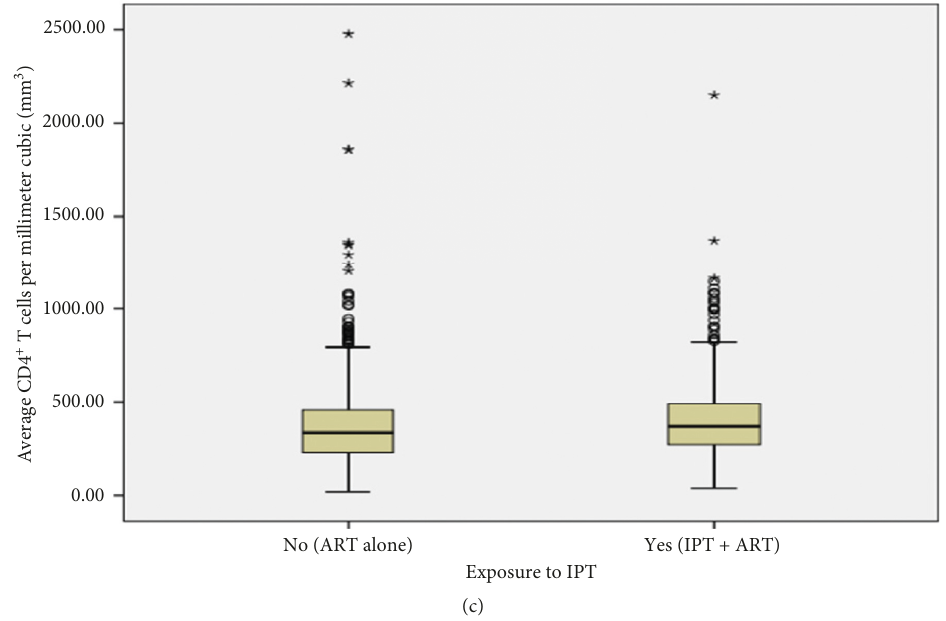
Figure 3: Trend of CD4 + T cells per millimeter cubic among patients living with HIV/AIDS taking IPT and ART versus ART alone in Northern Ethiopia, 2009–2017. (a) Overall CD4 + T cell trends; (b) trend comparison by cohorts; (c) mean CD4 + T cells comparison by cohorts. AIDS: acquired immune deficiency syndrome; ART: antiretroviral therapy; CD4+ Tcells: cluster of differentiation 4 positive Tcells; HIV: human immunodeficiency virus; IPT: isoniazid preventive therapy. Table 3: One-way ANOVA result of CD4 cells among patients living with HIV/AIDS taking IPTand ART versus ART alone in Northern Ethiopia, 2009–2017.